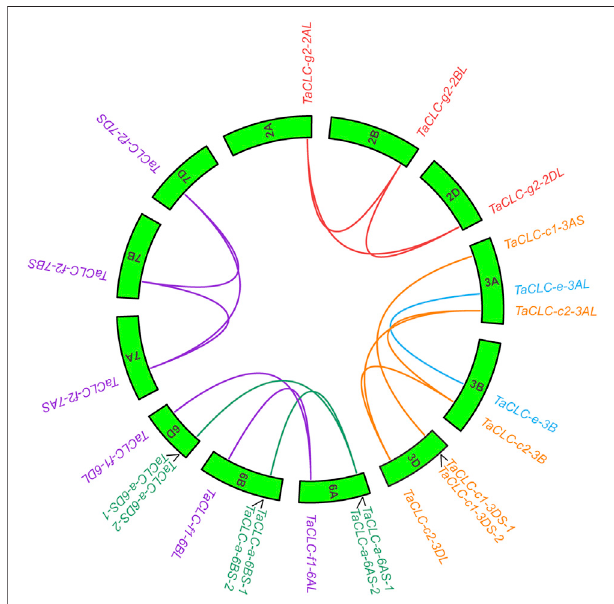
FIGURE 3 | Collinearity analysis of TaCLC genes. TaCLC genes in fi ve subfamilies (-a, -c, -e, -f, and -g) are represented by different colors of lines. Wheat chromosomes are represented by green boxes with chromosome names inside.